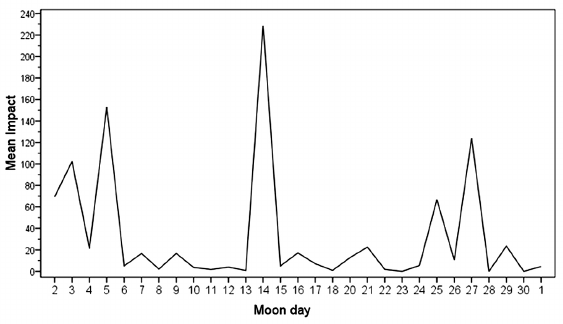
Fig. 5. – Evolution throughout the full moon cycle of the mean im- pact in the habitats of the node-2 habitats group (see text).